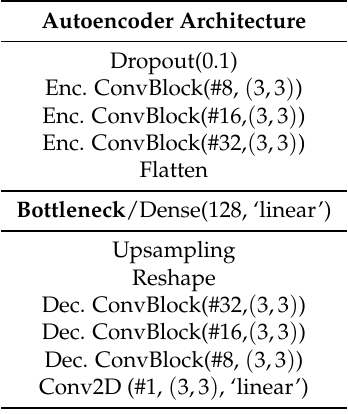
Figure 2. Architecture of the ConvBlocks for the two parts of the autoencoder. X l denotes the input to the block, while X l + 1 denotes the output. Table 1. Autoencoder architecture. Values preceded by # correspond to the number of filters and values in parenthesis correspond to kernel